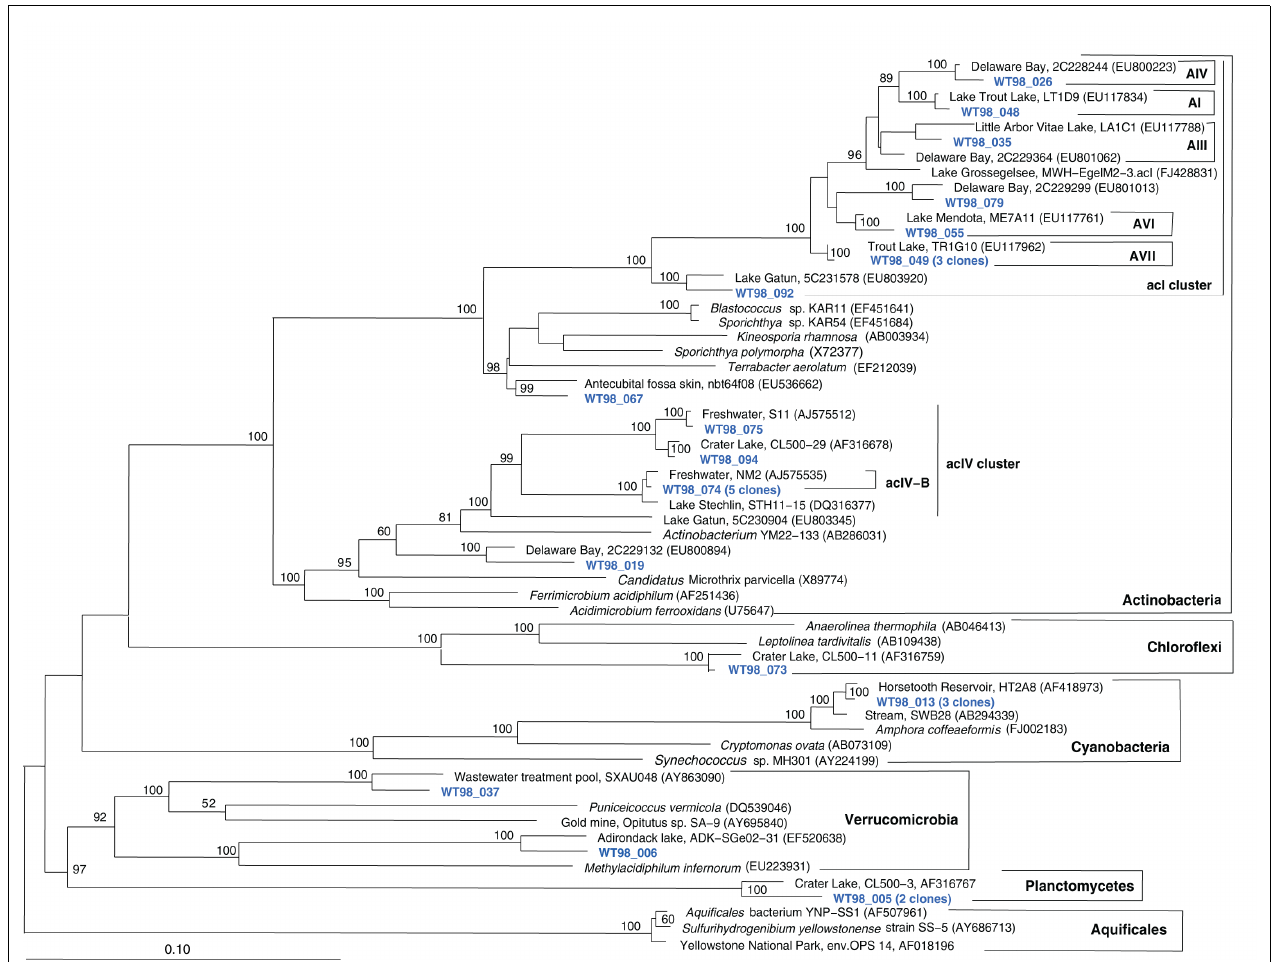
FIGURE 7 | Phylogeny ofWestThumb 98 bacteria except Proteobacteria, based on E. coli 16S rRNA gene nucleotide positions 25–1491.